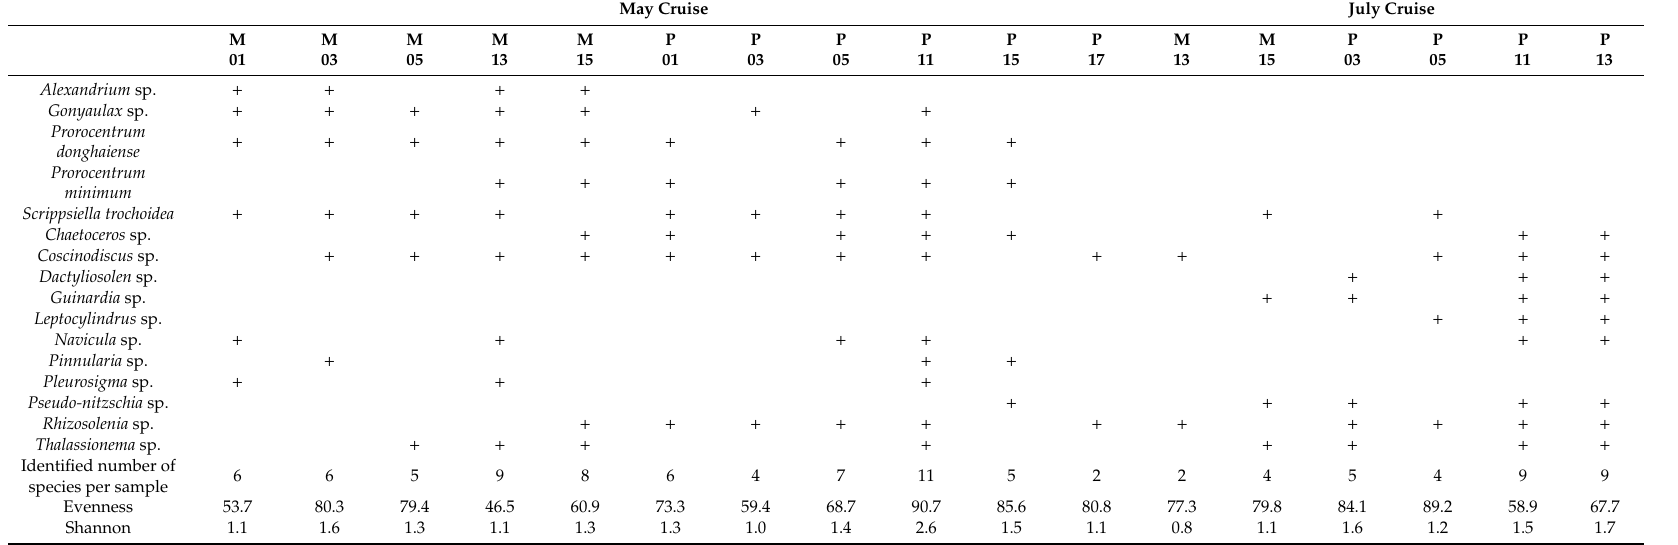
Table 1. Identified dominant dinoflagellate and diatom species, phytoplankton evenness (%), and Shannon’s diversity index (bits ind –1 ) in the surface water of the Taiwan Strait during the cruises in May and July 2019. ‘ + ’ indicates presence of the given phytoplankton species in the sampling